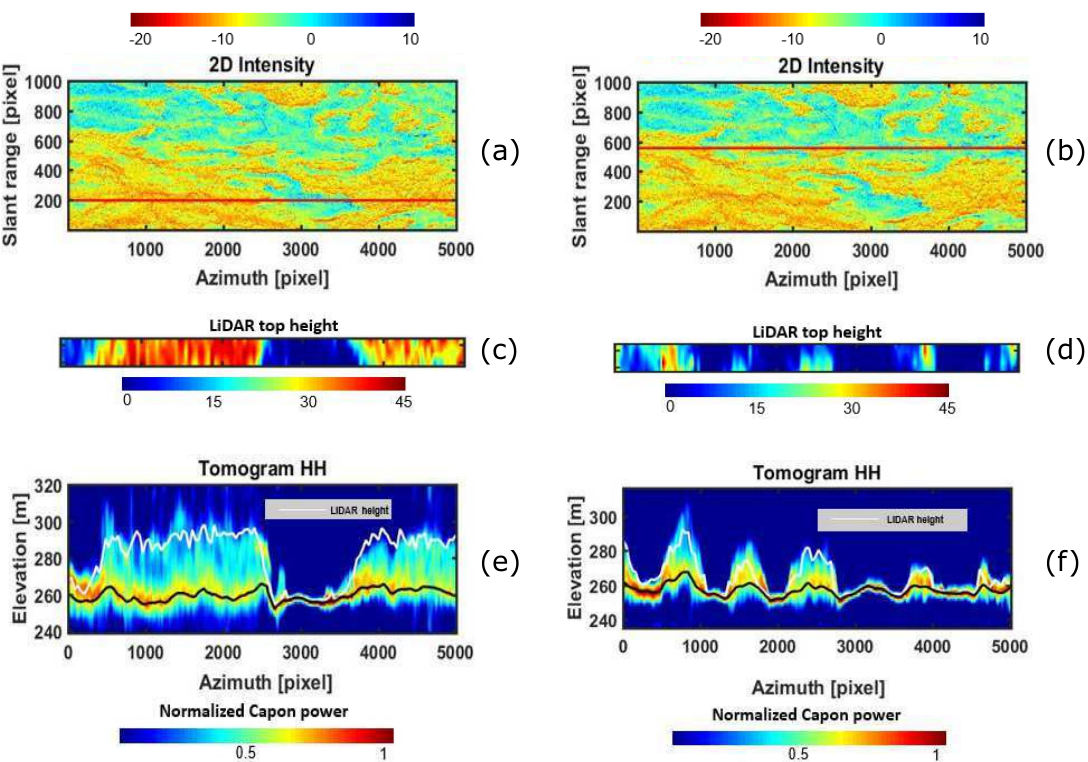
Figure 5. ( a , b ) The 2-D intensity of the TomoSAR image; the red lines correspond to the slant range positions where the cut was chosen. ( c , d ) The Lidar cut at two slant range positions 200 and 590, respectively. ( e , f ) HH Capon spectra. The black and white lines in (e,f) correspond to the digital terrain model (DTM) and canopy height model (CHM) from small-footprint Lidar (SFL), respectively. Capon power was normalized between 0 and 1 to enhance visualization of the scatterers.